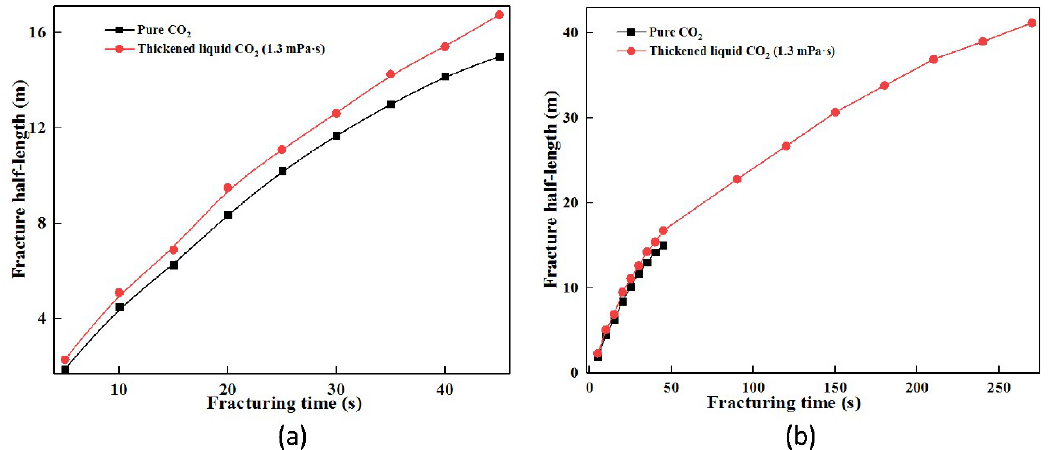
Figure 8. The effect of EEPDMS on the fracture half-length in CO 2 fracturing operation. ( a ) 0–44 s; ( b ) 0–270 s.